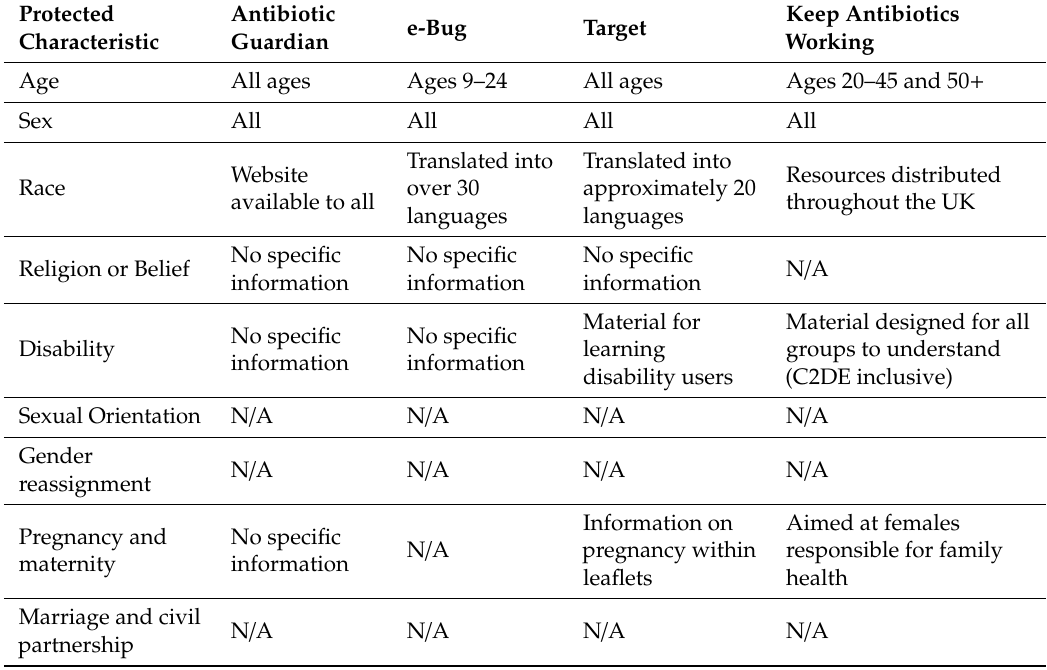
Table 1. Campaign assessment of the protected